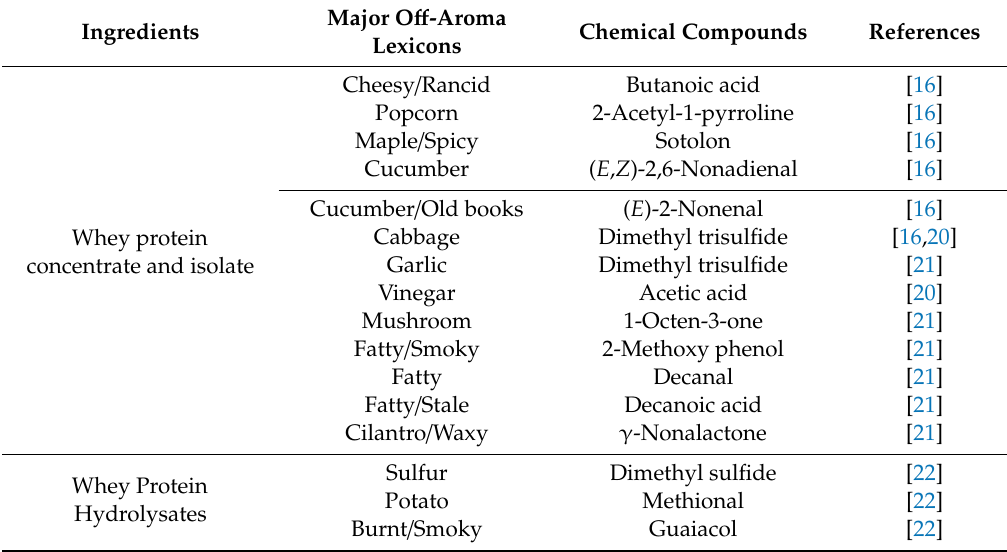
Table 1. Sensory lexicons and chemical natures of selected off-aroma compounds in major dairy